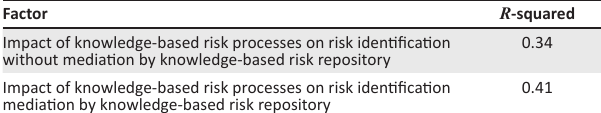
TABLE 4: R -squared